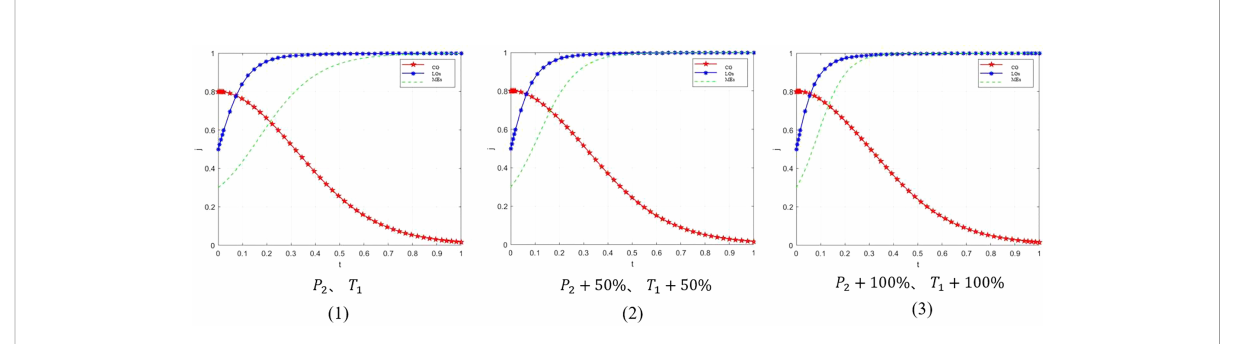
FIGURE 8 The impact of LGs ’ penalties on the